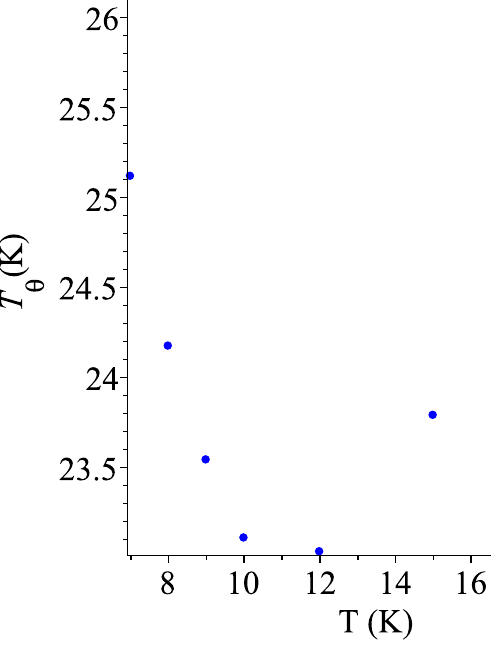
Figure 2. QLT regime of grey tin, Ref. 39